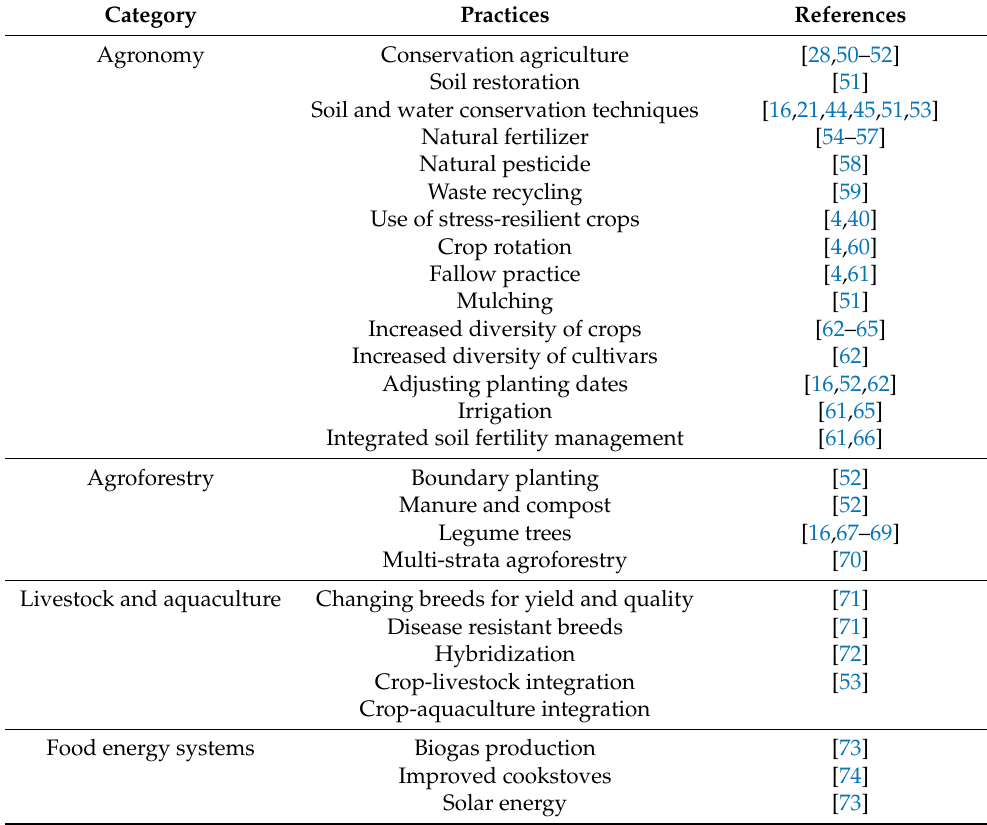
Table 1. Most popular CSA practices in